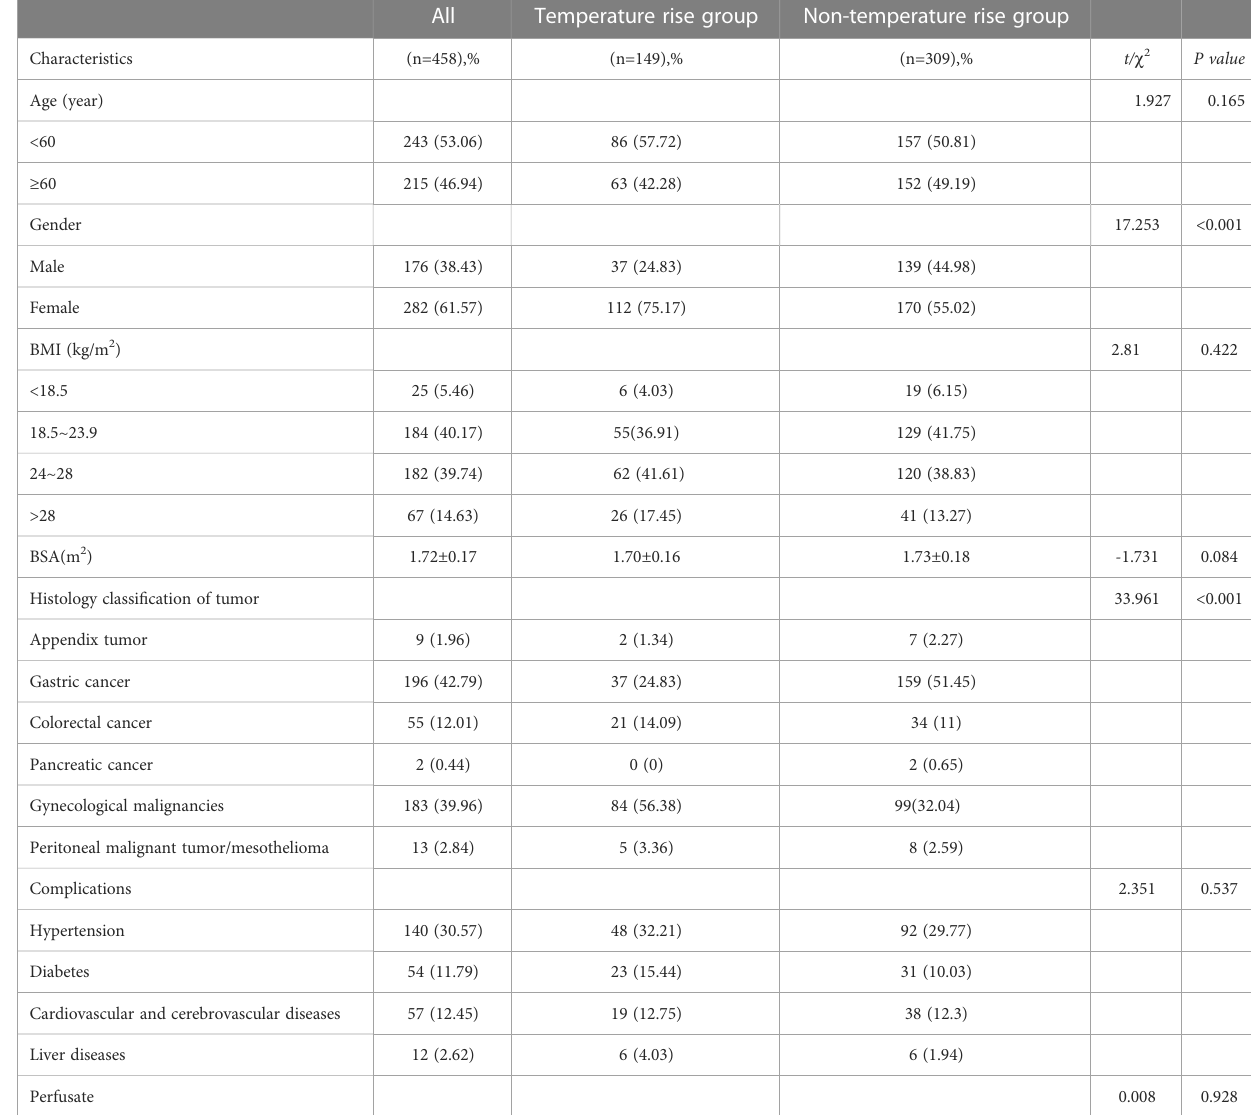
TABLE 1 Demographics and clinical data of patients.